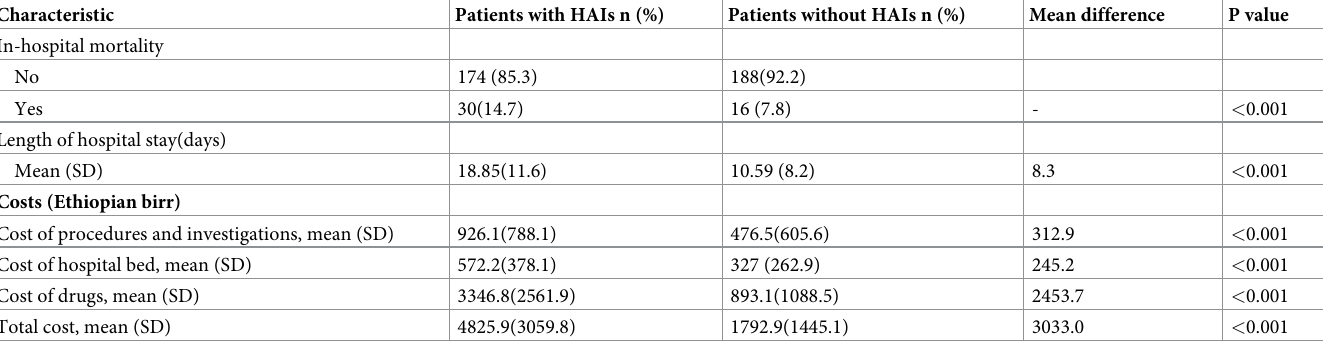
Table 3. Clinical and economic burden of patients with and patients without healthcare-associated infections at ACSH, Nov. 2019-Mar. 2020.